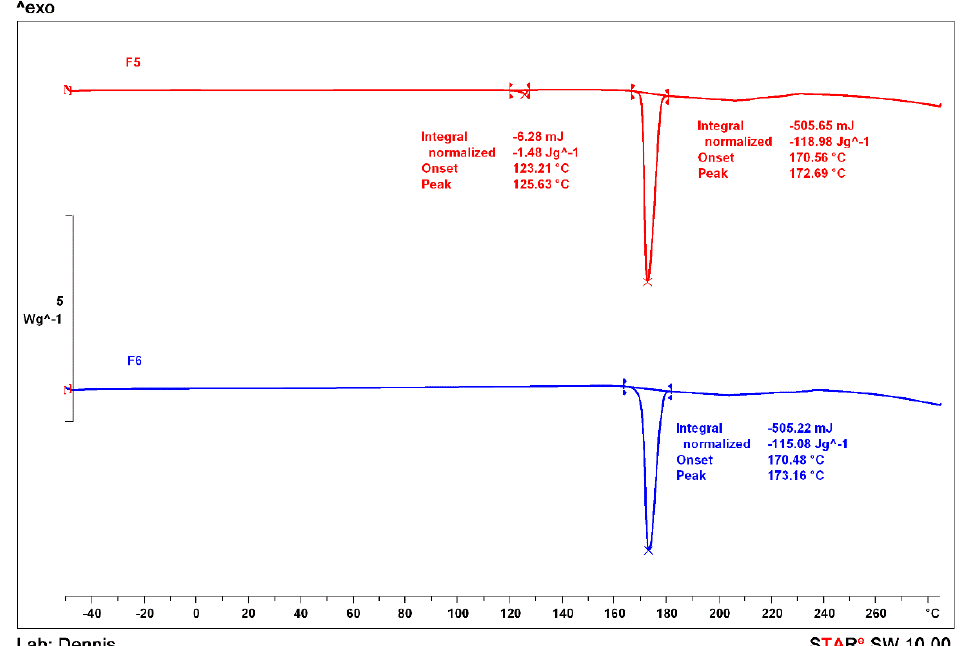
Figure 6. DSC thermogram of THL-NIC cocrystals after scaling up to 1.5 kg/h.